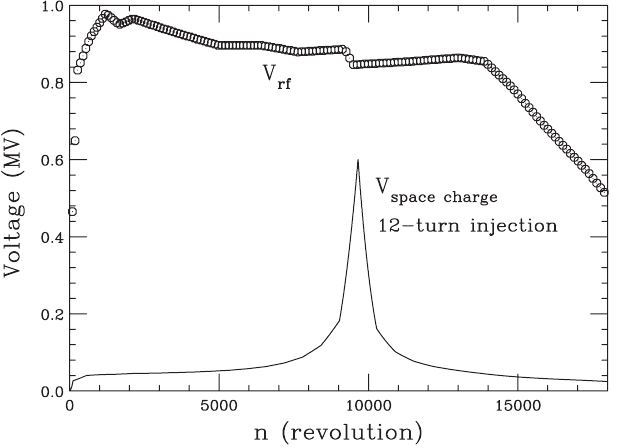
to the model of Eq. (19) for 5-turn x to the model of Eq. (19) for 10-turn x